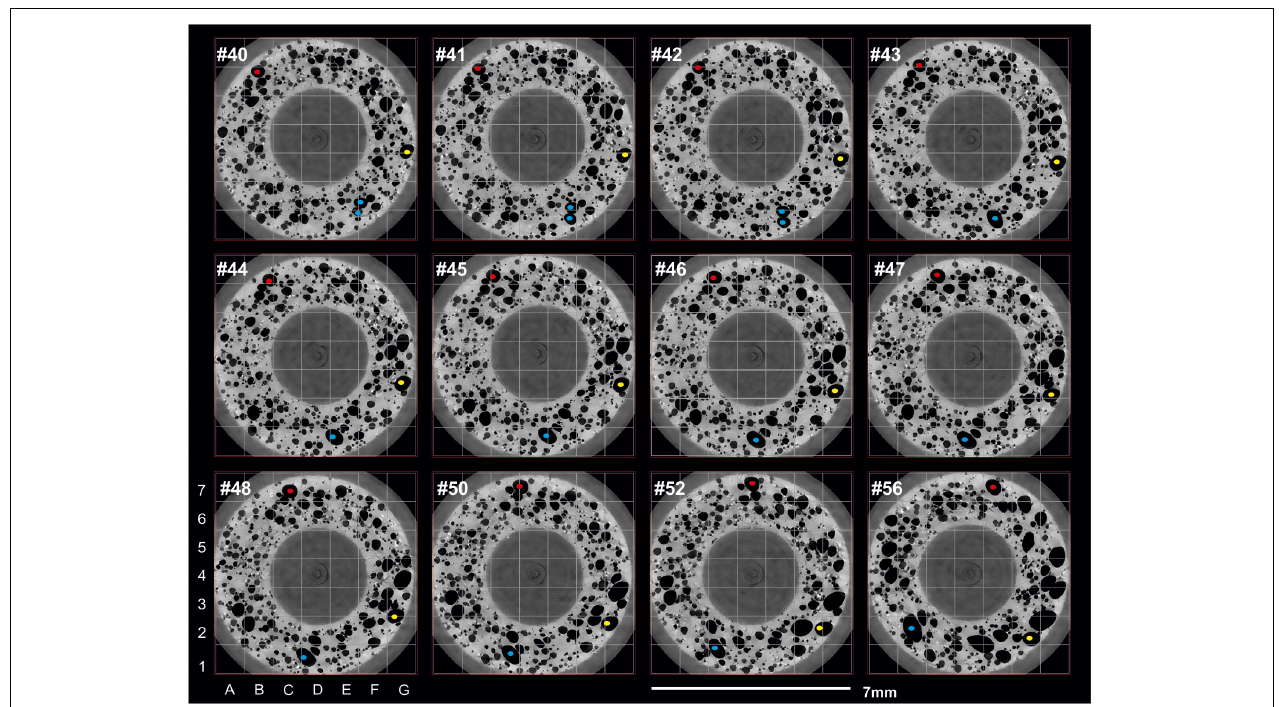
FIGURE 6 | Two-dimensional grayscale slices perpendicular to the rotation axis showing the deformation and coalescence in the mid slice tomographies between #40 and 54 during the acceleration to 0.3 rpm differential rotation. Three bubbles are highlighted (red, yellow, blue) see text for details. Note that bottom row of images shows every other